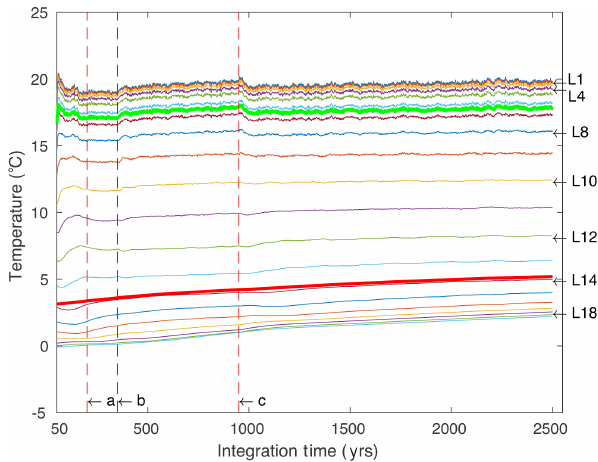
Figure 2. Time evolution of the globally integrated temperature for the ocean layers within the Eoi 400 experiment. Whole ocean vol- ume is indicated by the thick red line and the top 200m are in- dicated by the thick green line. Vertical lines indicate key spin-up stages: (a) adding the barotropic physics to the ocean model, (b) in- corporation of barotropic streamfunction islands into the barotropic solver and (c) correction to the barotropic streamfunction island in the southern high latitudes and incorporation of full PRISM4 veg- etation boundary conditions into the model. The midpoints to the ocean layers are 5m (L1), 15m (L2), 15m (L3), 35m (L4), 48m (L5), 67m (L6), 96m (L7), 139m (L8), 204m (L9), 301m (L10), 447m (L11), 666m (L12), 996m (L13), 1501m (L14), 2116m (L15), 2731m (L16), 3347m (L17), 3962m (L18), 4577m (L19) and 5195m